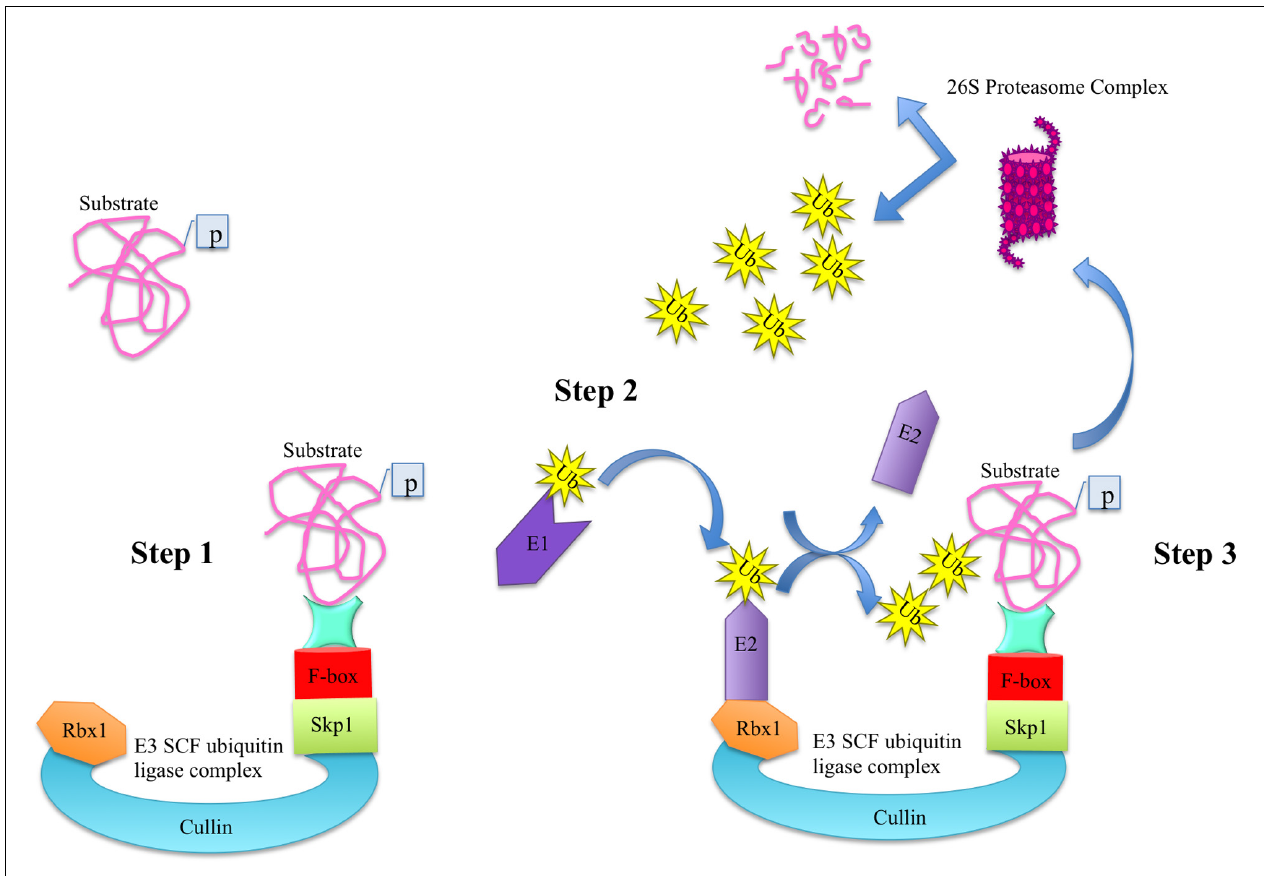
FIGURE 1 | The ubiquitin-dependent protein degradation pathway. The degradation of substrate proteins via ubiquitin-dependent proteasome degradation pathway consists of three main steps. In step 1, the phosphorylated substrate is attached to the C-terminal domain of F-box protein of E3 ligase complex. In step 2, the ubiquitin-activating ligase enzyme E1 activates the ubiquitin molecules and transfers them to E2 conjugating enzyme, which is attached to Rbx1 of E3 ligase. Upon conjugation, the E3 ligase transfers the ubiquitin molecules to the substrate in step 3 and is free to enter in the second round of conjugation. Once a protein is marked with ubiquitin moieties, it is degraded into its constitute molecules via proteasome